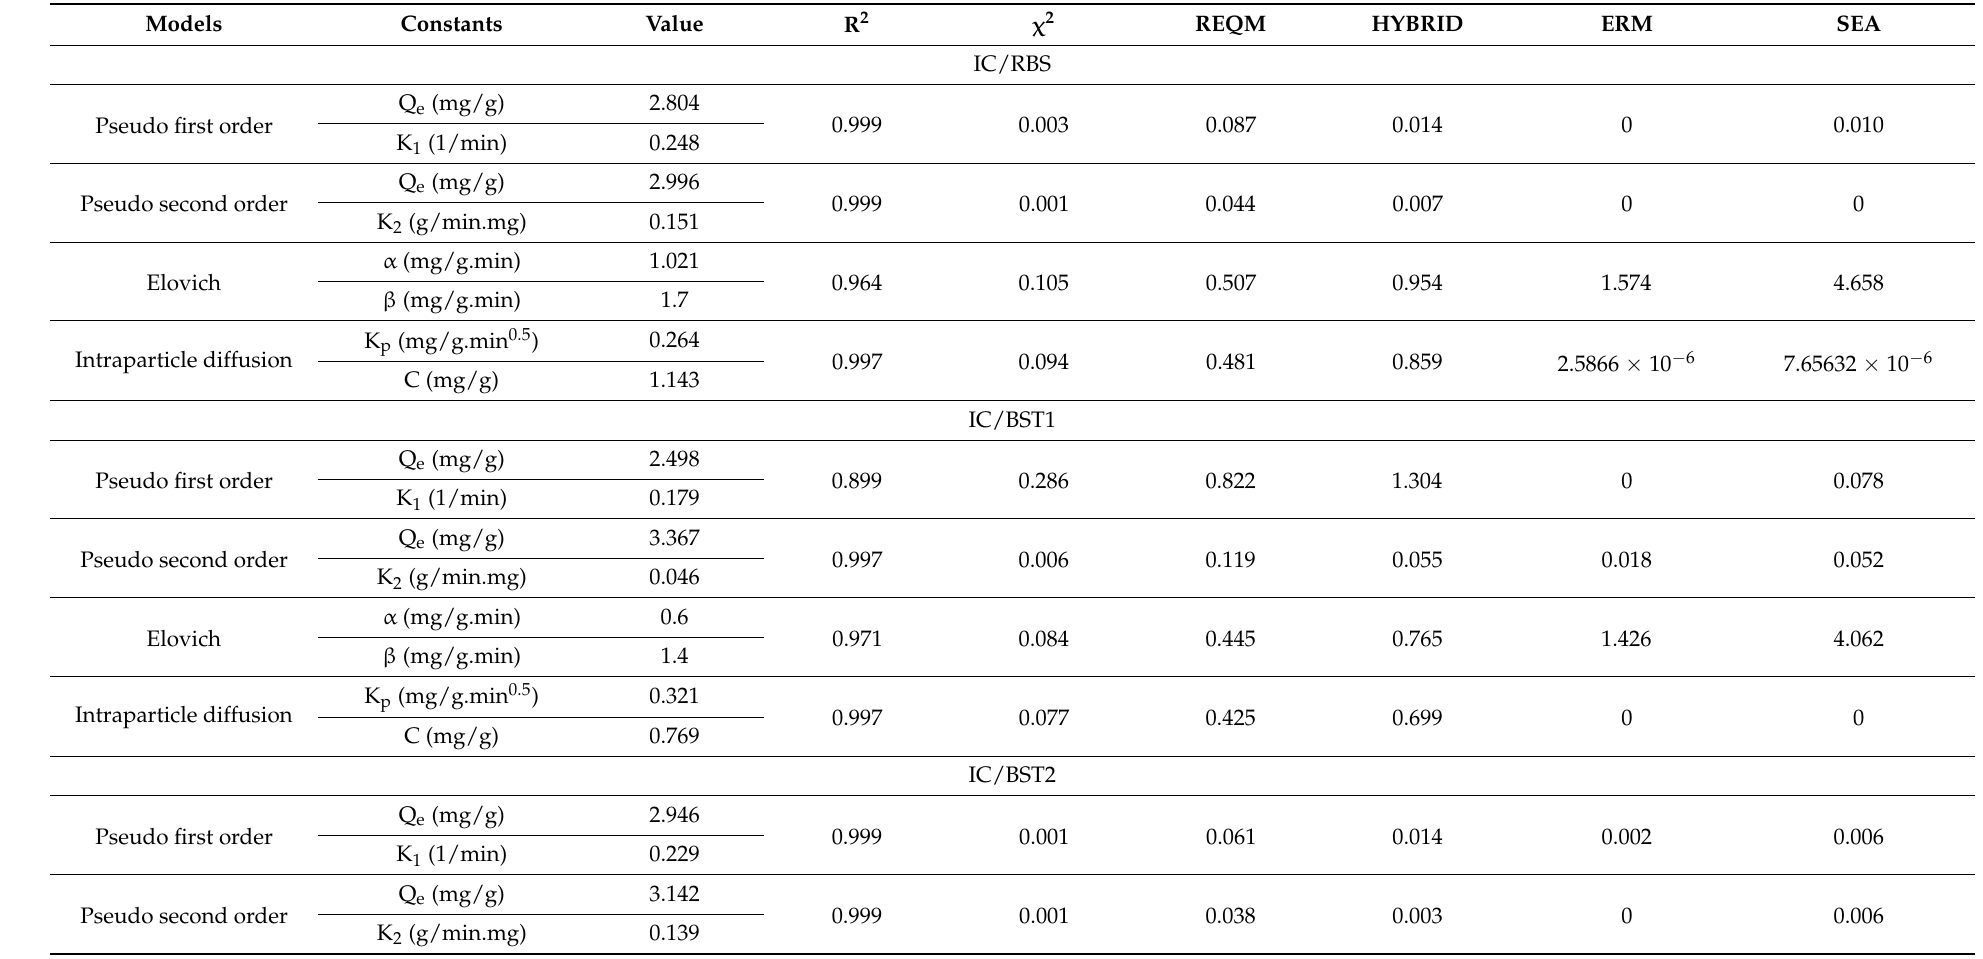
Table 5. Values of the constants of the nonlinear kinetics models for the biomasses RBS, BST1 and